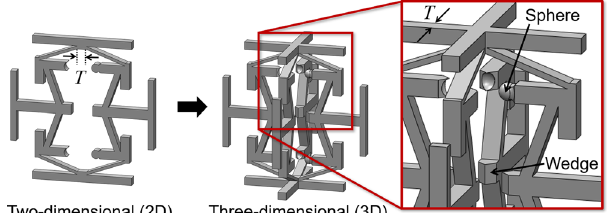
Fig. 7 Two-dimensional (2D) designs can be transformed into three- dimensional (3D) versions that achieve the same alternating Poisson ’ s ratio. These 3D versions are generated by rotating a copy of their 2D version 90° about its central axis. Some 2D-version hard stops need to be adapted for the 3D version to function with the same alternating Poisson ’ s